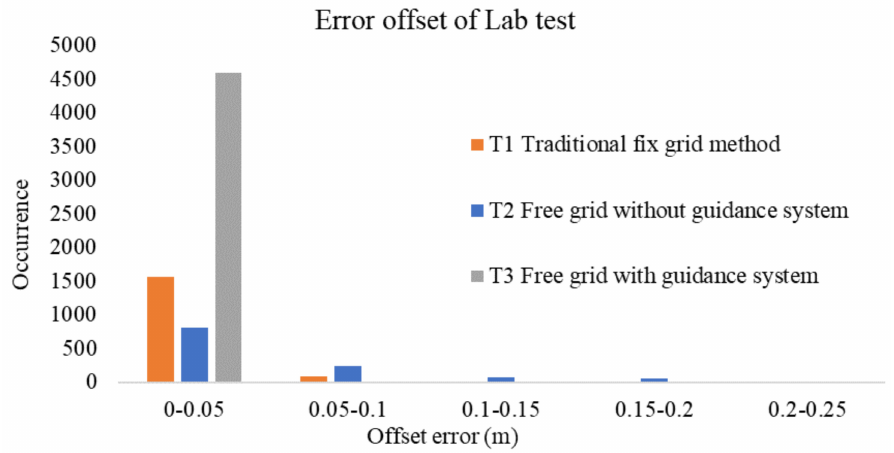
Figure 10. Distribution of the offset errors from three paths in the laboratory